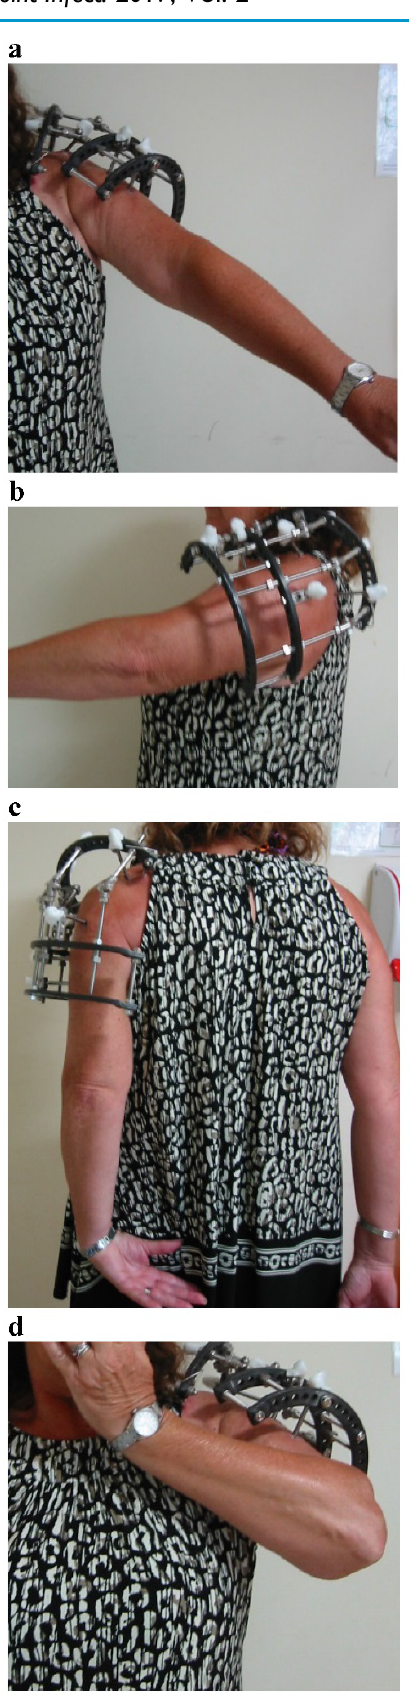
Figure 5 . (a to d). Functional range at 8 weeks after frame